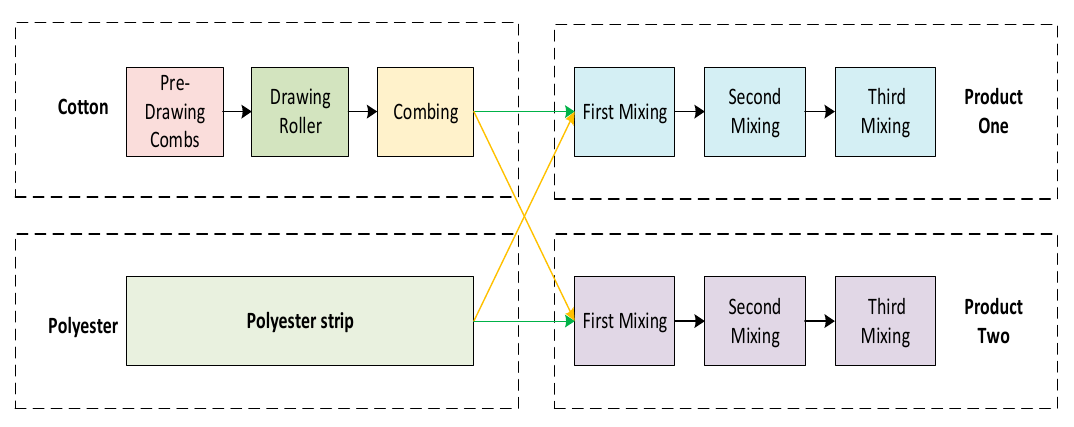
Figure 9. Process flow diagram.